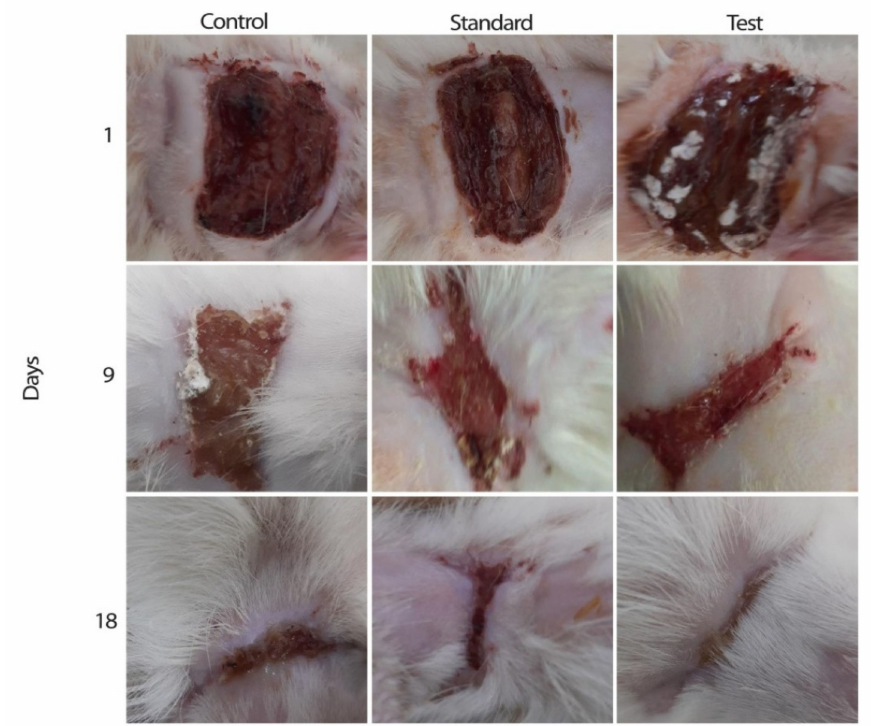
Figure 32. Photographs of wound areas of the diabetic group of rats on 1, 9, and 18th days after treat- ment with Control, Standard, and PM-CS NPs H-1 (test treated) [208]. Reproduced with permission from Elsevier